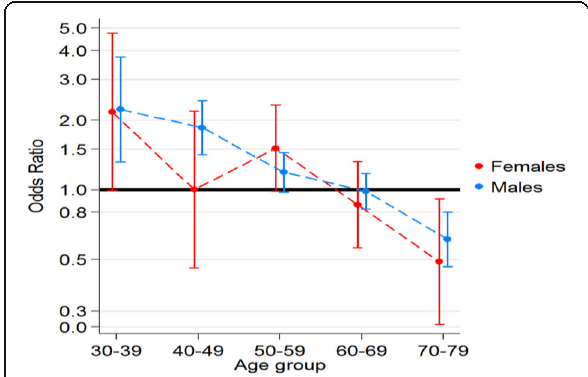
Fig. 3 Odds ratios of anti-Glaucoma medication in anti-HIV prescription population compared to 2016 Australian